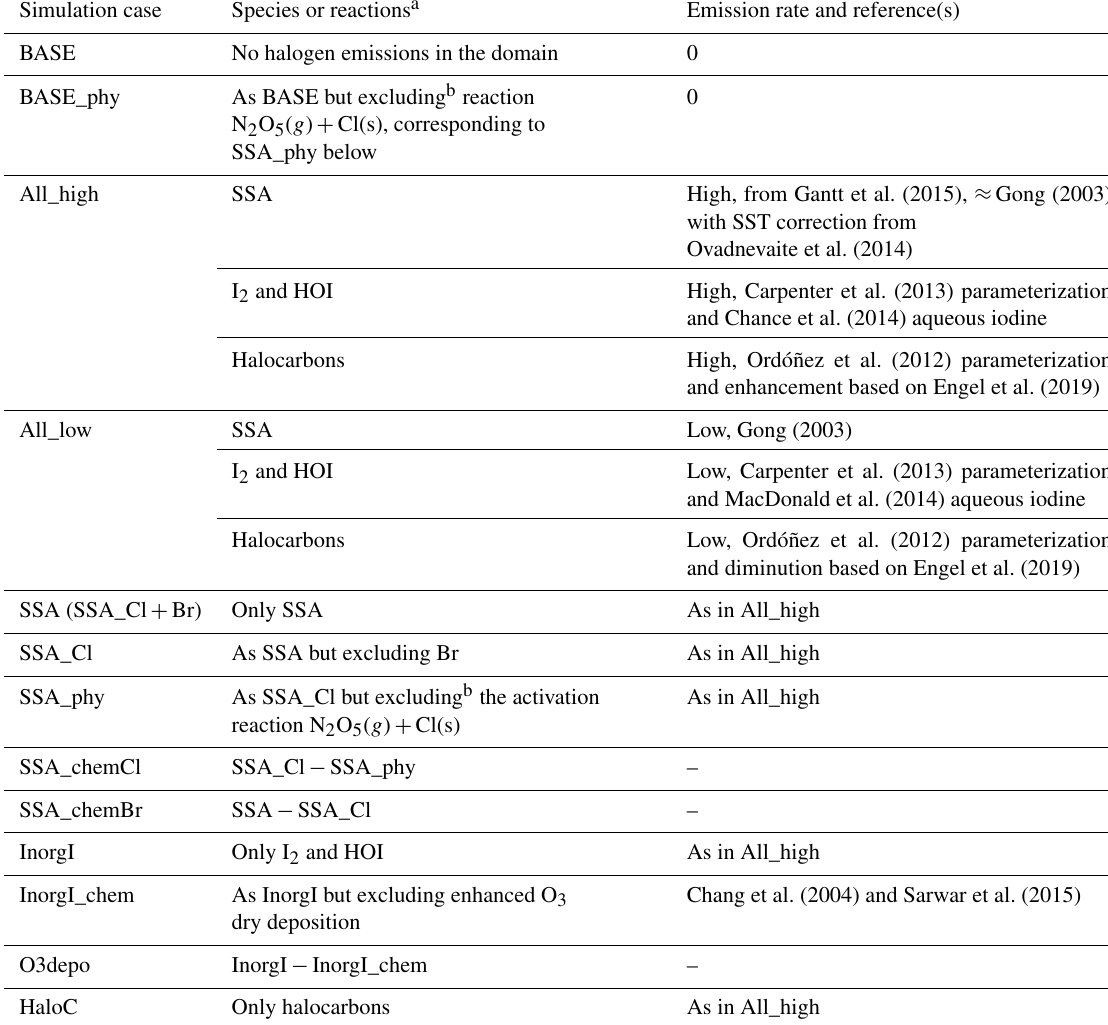
Table 1. Case design in this study. Simulation case